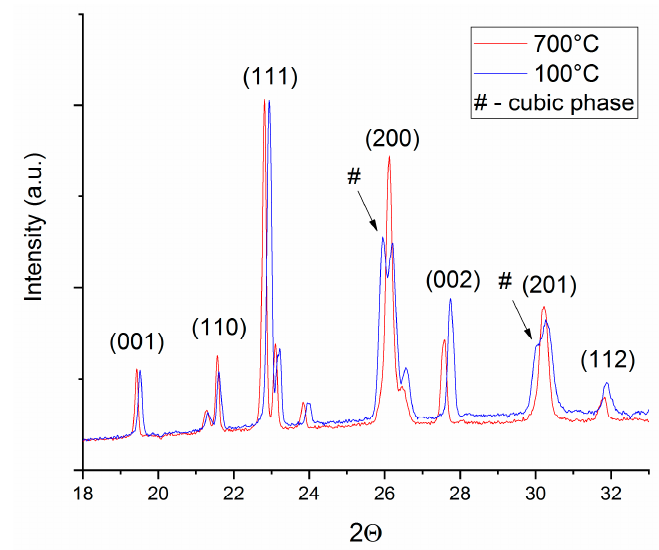
Figure 4. Details of the synchrotron XRD data recorded at 100 °C (blue) and 700 °C (red).